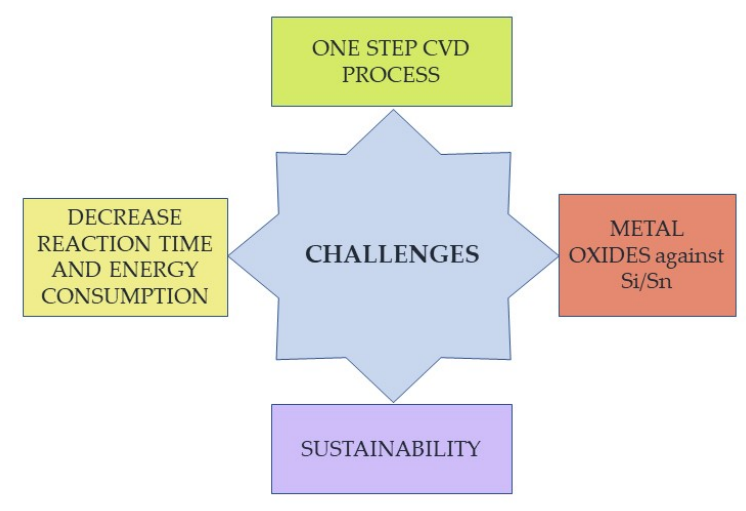
Figure 5. Challenges to overcome for the industrialization of CVD process.